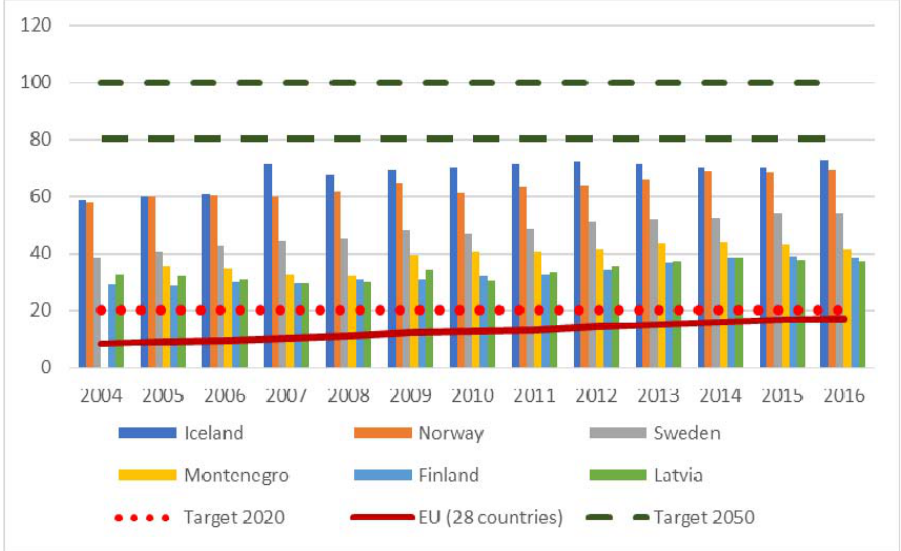
Fig. 1. Share of renewable energy in gross final energy consumption in EU Source: Eurostat (2018).